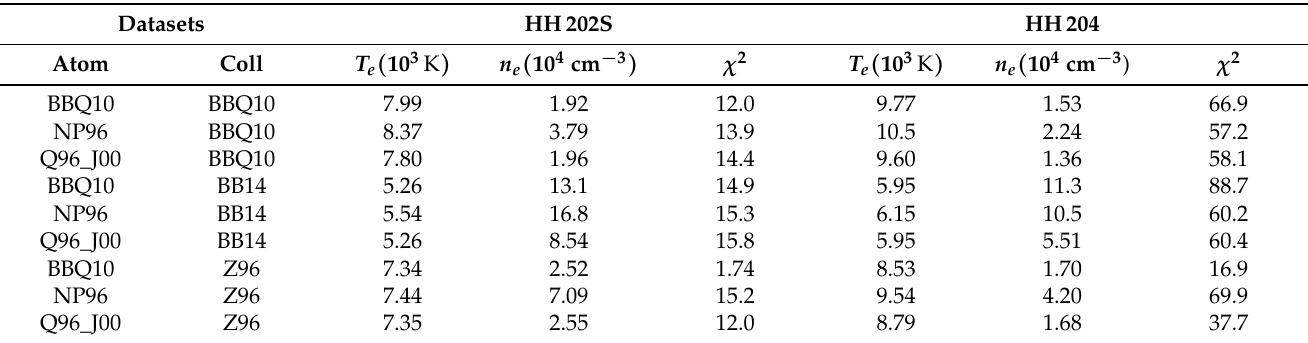
Table 4. Temperature and density fits of the [Fe III ] observed spectra of HH202S and HH204 with the radiative ( atom ) and collisional ( coll ) datasets available in PyNeb 1.1.16.